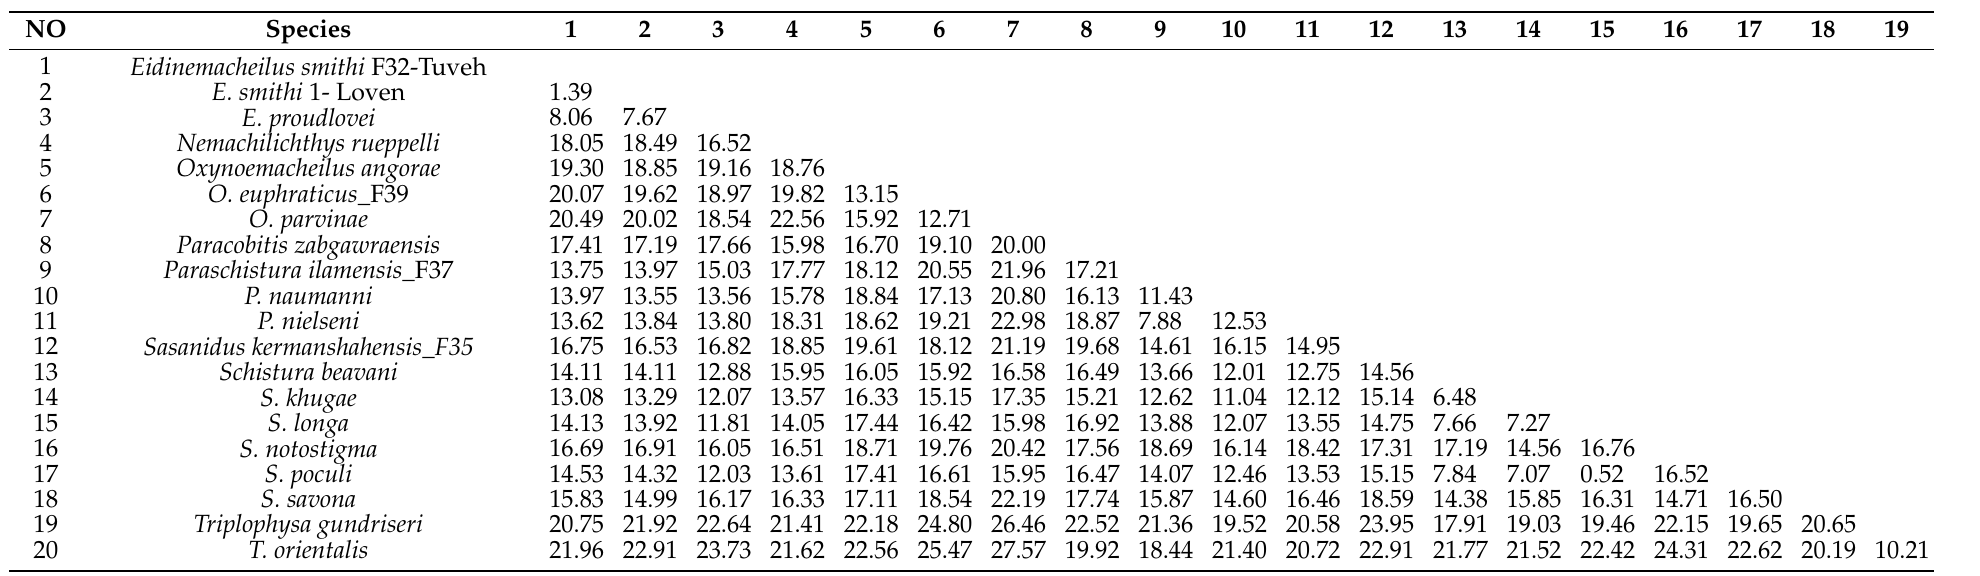
Table 3. Estimates of the average COI divergence (K2P distance) between examined Nemacheilidae